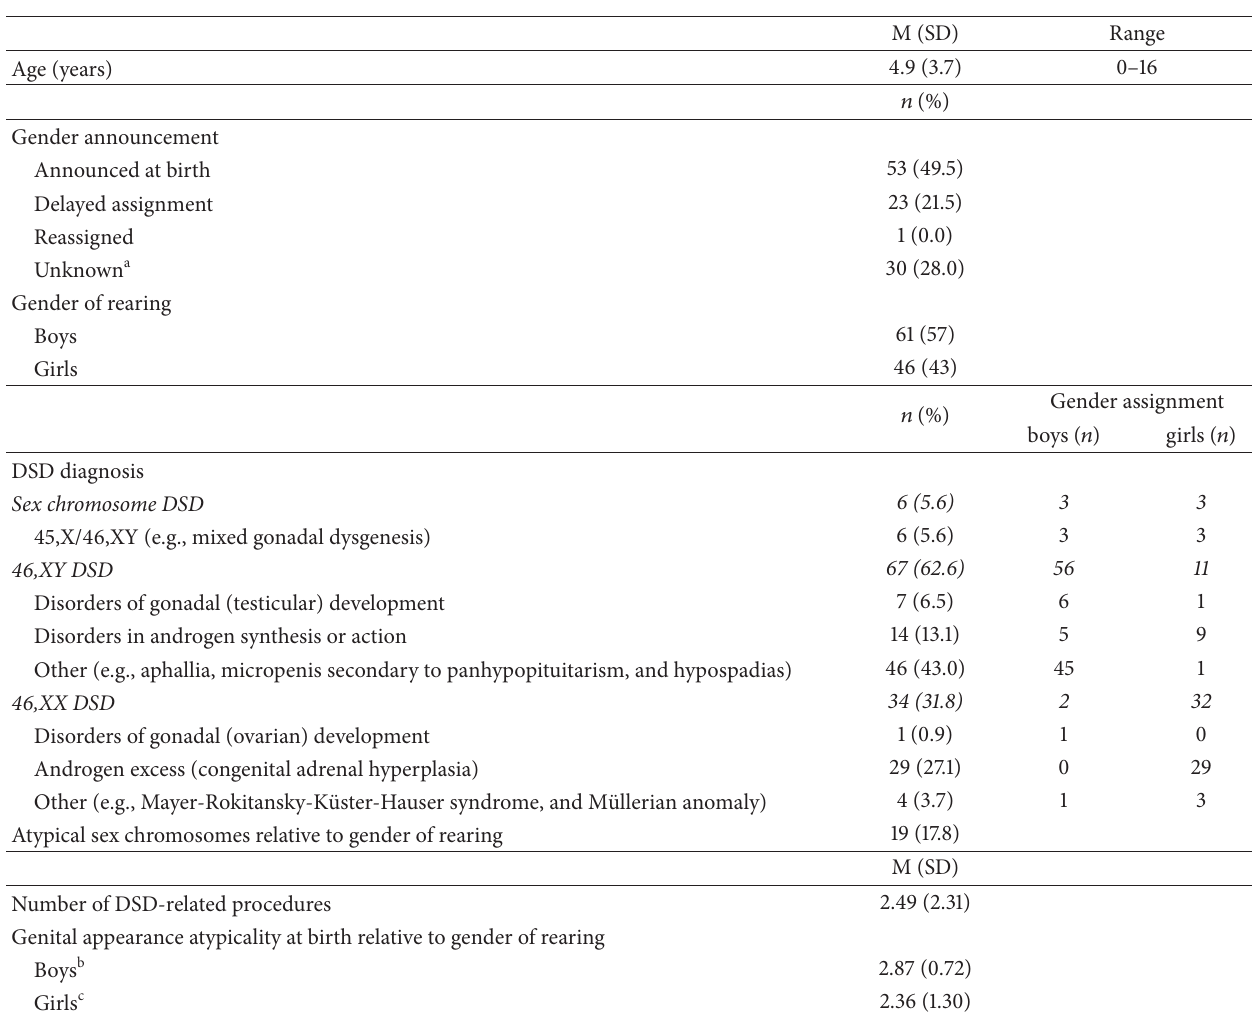
Table 3: Index case characteristics ( 𝑛 = 107